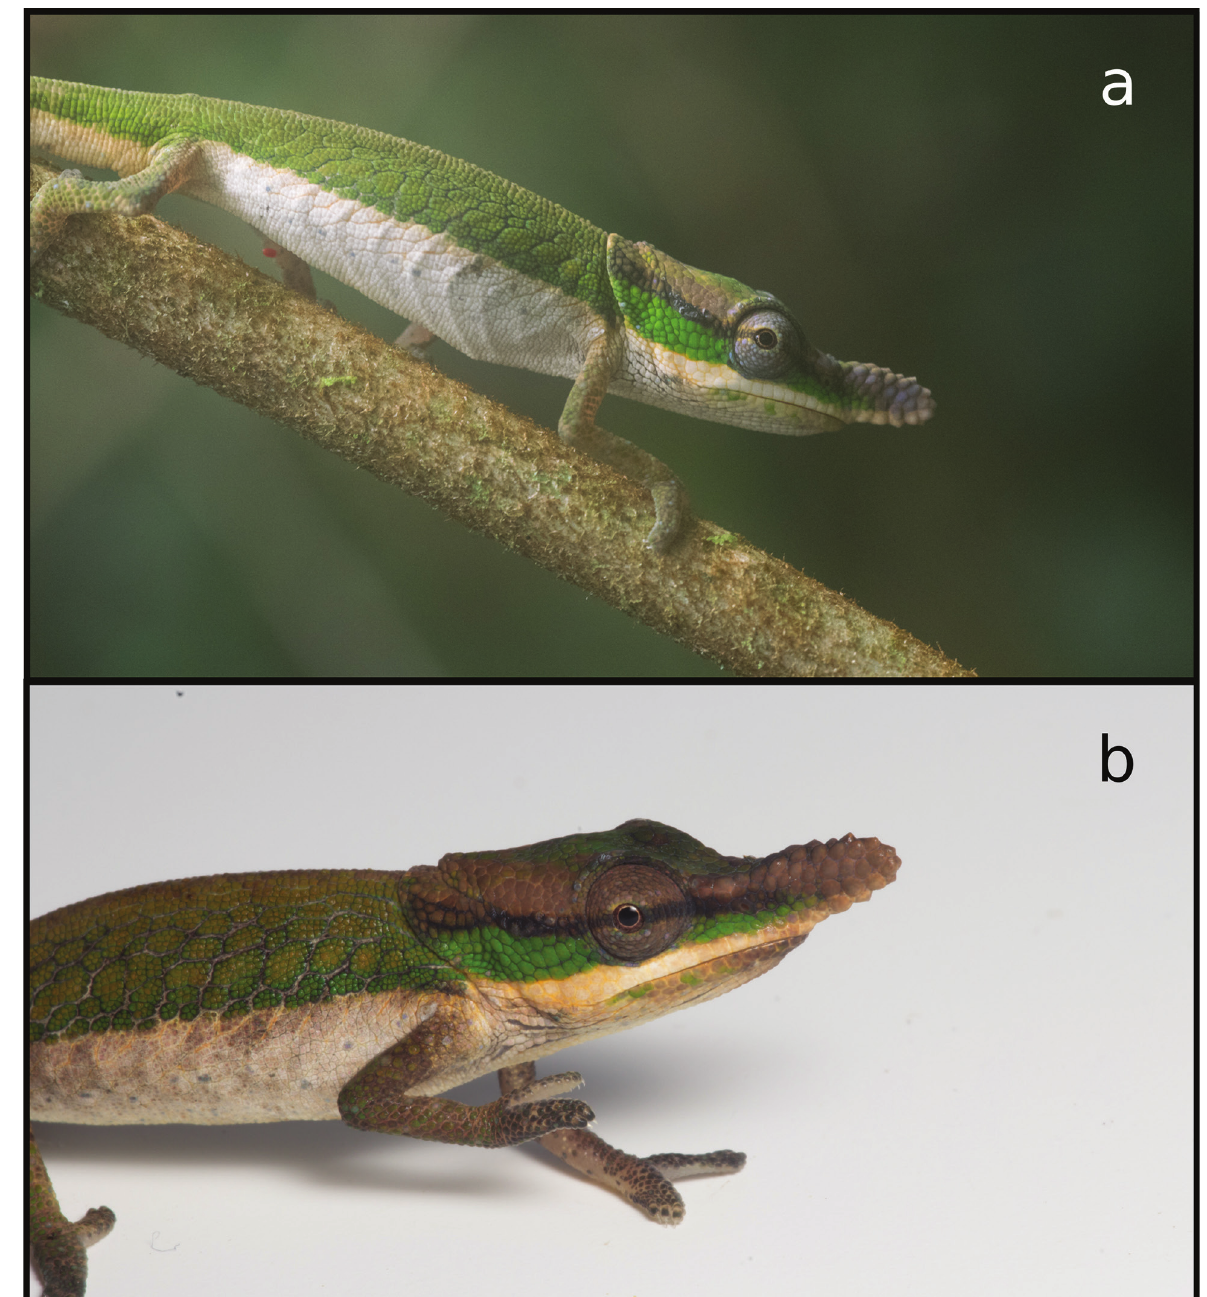
Figure 6. Posed photos of a subadult male specimen of Calumma roaloko sp. n. (ZSM 244/2018, KU 343177); ( a ) Indigo coloration on the rostral appendage and head scalation is apparent; ( b ) portrait of the same